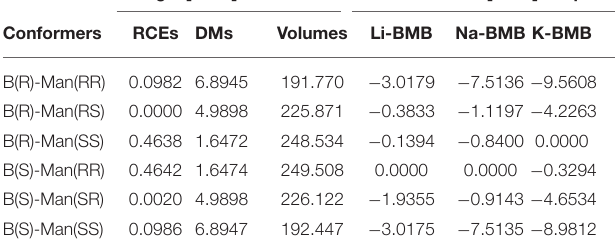
TABLE 1 | Relative conformational energies (RCEs) (in kJ/mol), dipole moments (DMs) (in Debye), and molecular volumes (in cm 3 /mol) of single [BMB] conformers, and relative binding energies (RBEs) (in kJ/mol) of varied [BMB] conformers in coordinating alkali metal ions (Li + , Na + , and K + ), as determined from DFT